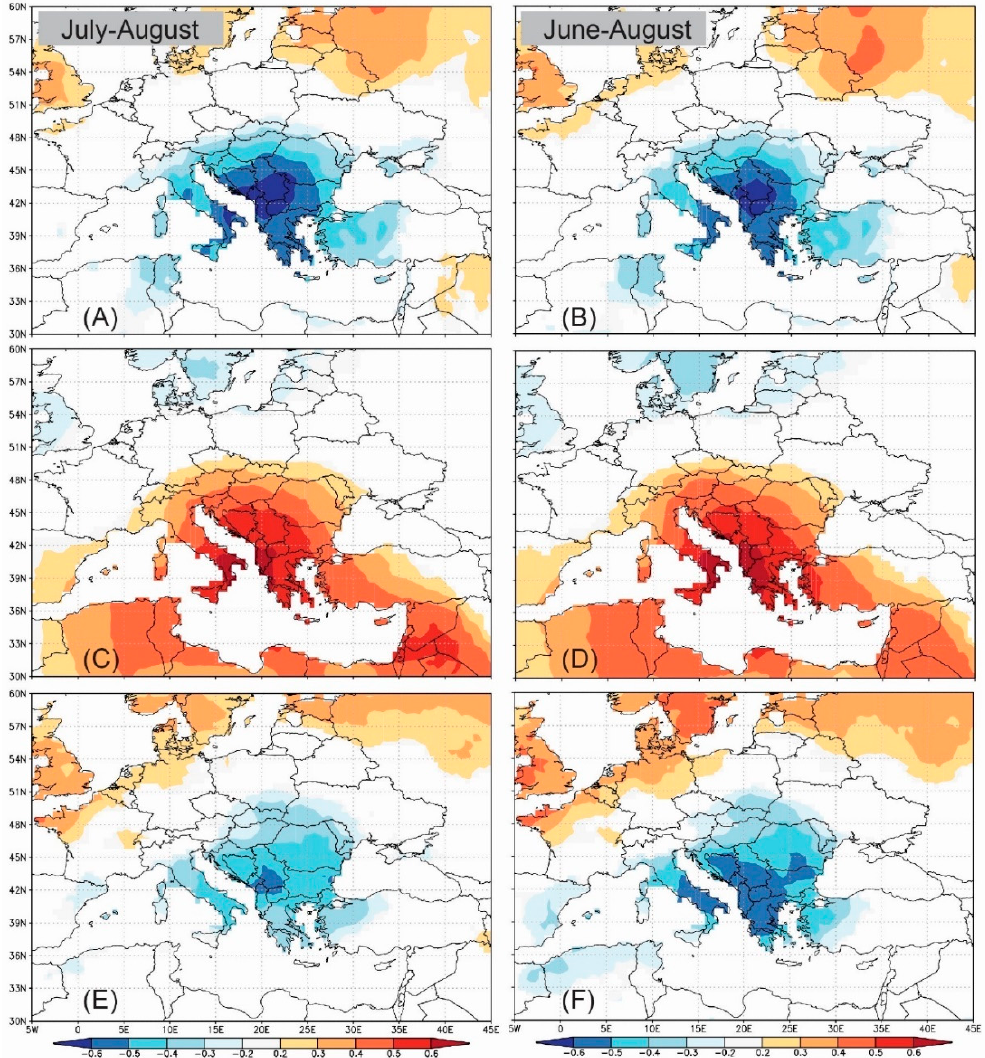
Figure 8. Spatial field correlation (p < 0.05) between CRU TS dataset summer temperature and δ 13 C composite Pinus chronology. ( A,B ) present the spatial field correlation with July–August and June–August cloudiness, respectively. ( C , D ) present the spatial field correlation with July–August and June–August temperature, respectively. ( E , F ) present the spatial field correlation with July–August and June–August precipitation,